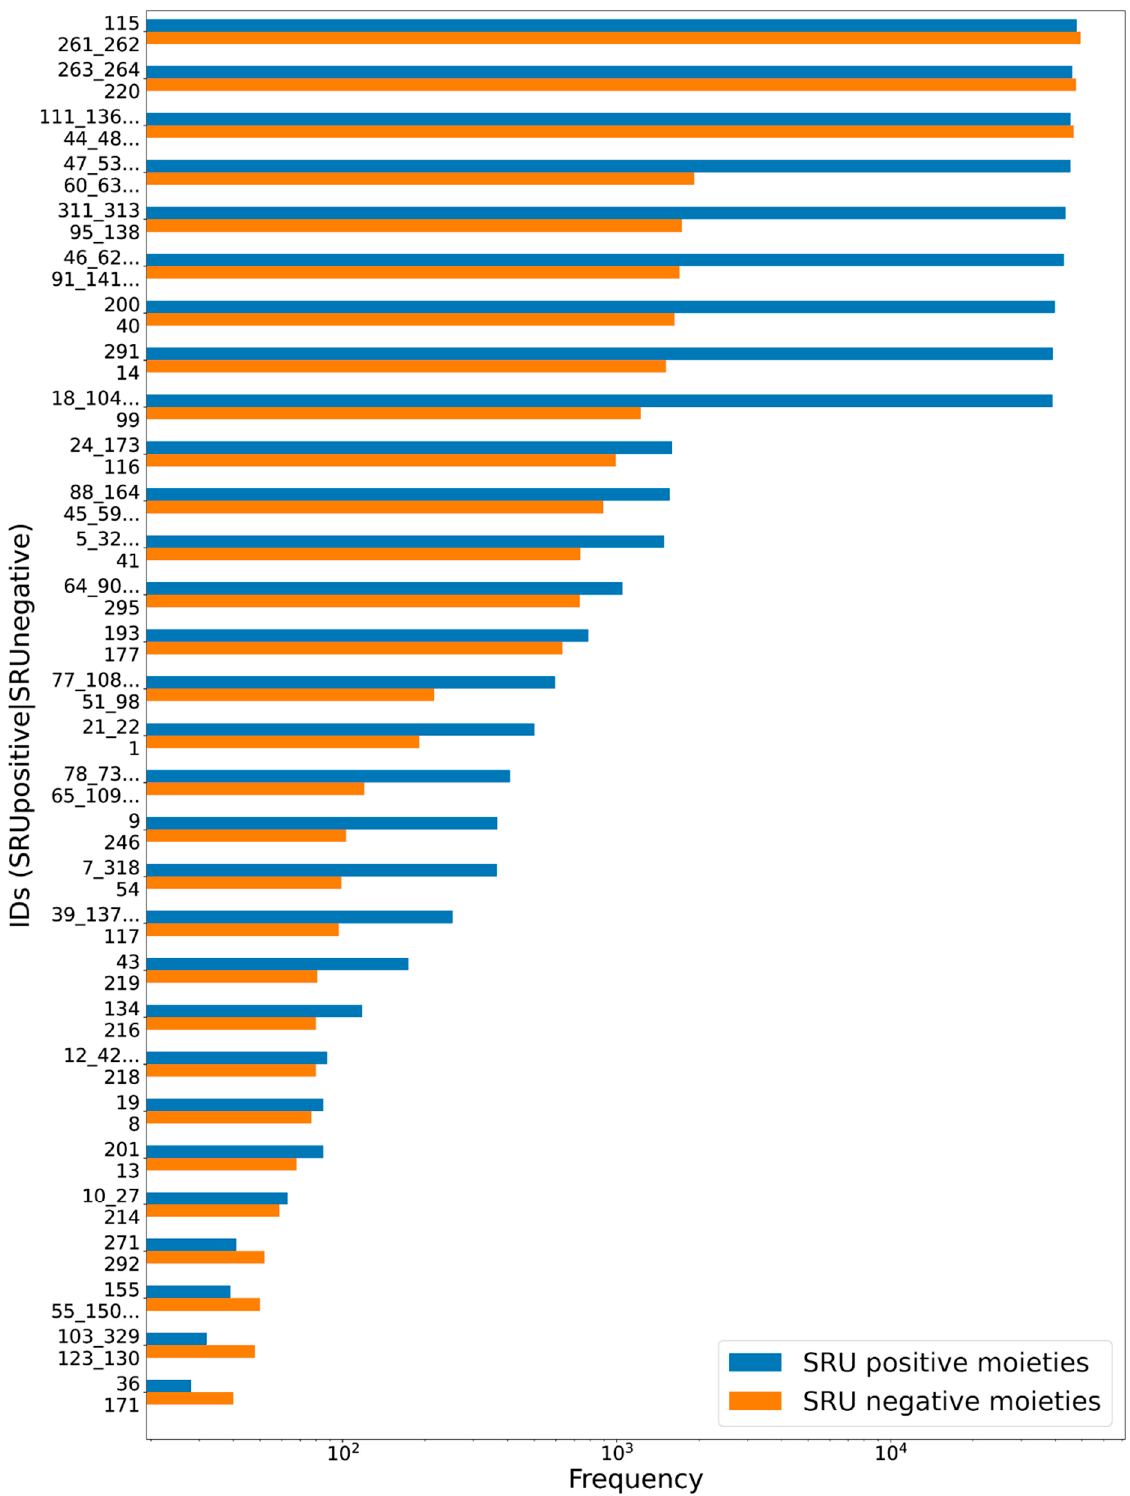
Figure 12. Frequencies of glycosidic moieties reported in bacterial NPs in COCONUT, grouped for detectability by the SRU using default settings. Sugar moieties detectable by the SRU are denoted “SRU positive moieties” (blue bars), and the remaining are denoted “SRU negative moieties” (orange bars). The ID on the vertical axis refers to the identifiers used in the original publication of the dataset, concatenated where stereoisomers were grouped. Frequencies, as detected by substructure matching, are in log-scale. Only moieties with at least ten matches in COCONUT were considered, and out of these the 30 most frequent are listed, respectively.